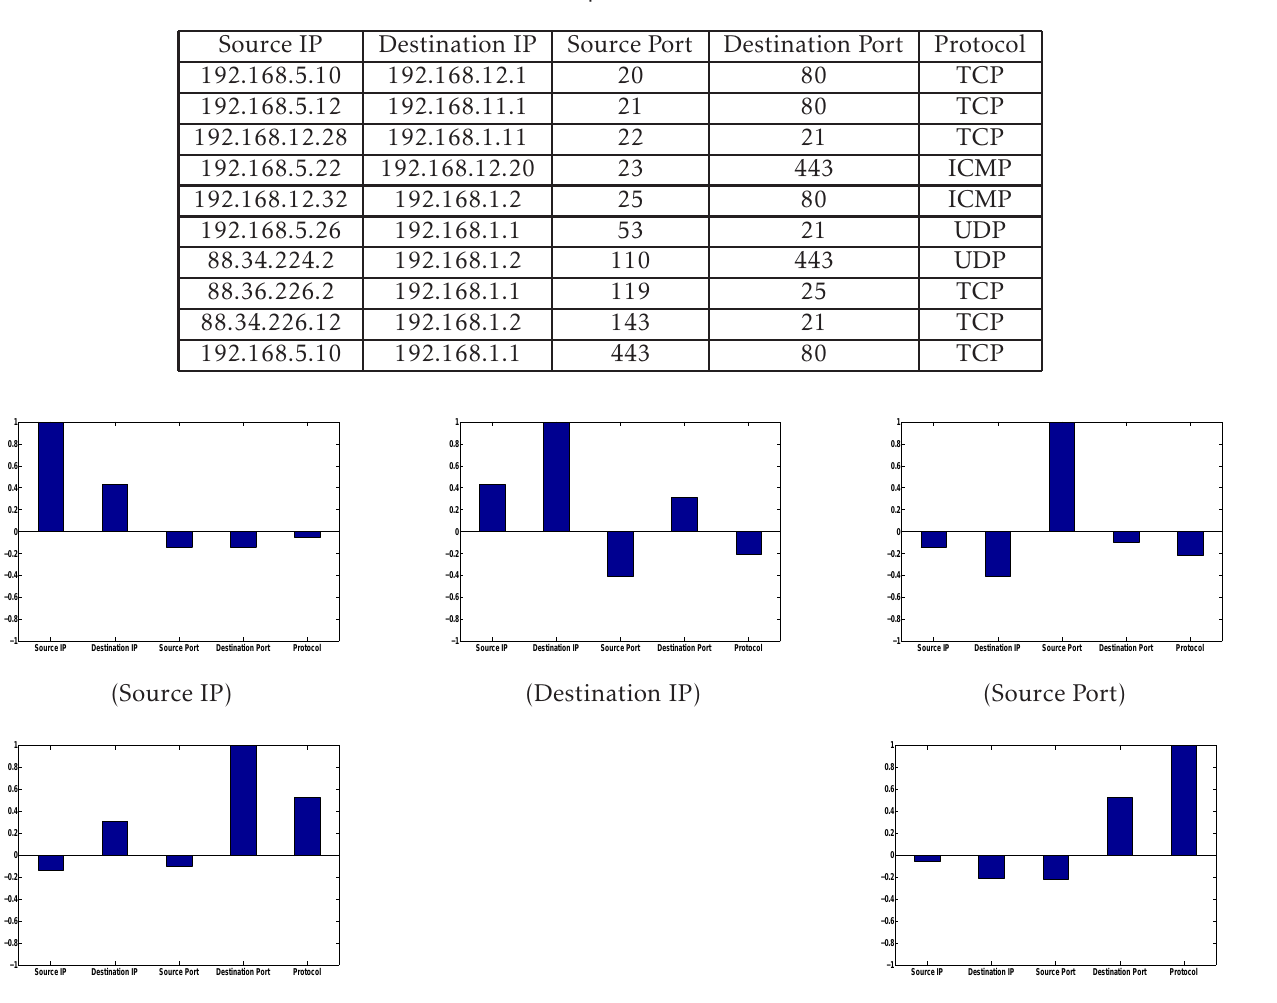
Table 1. A sample of Network traffic